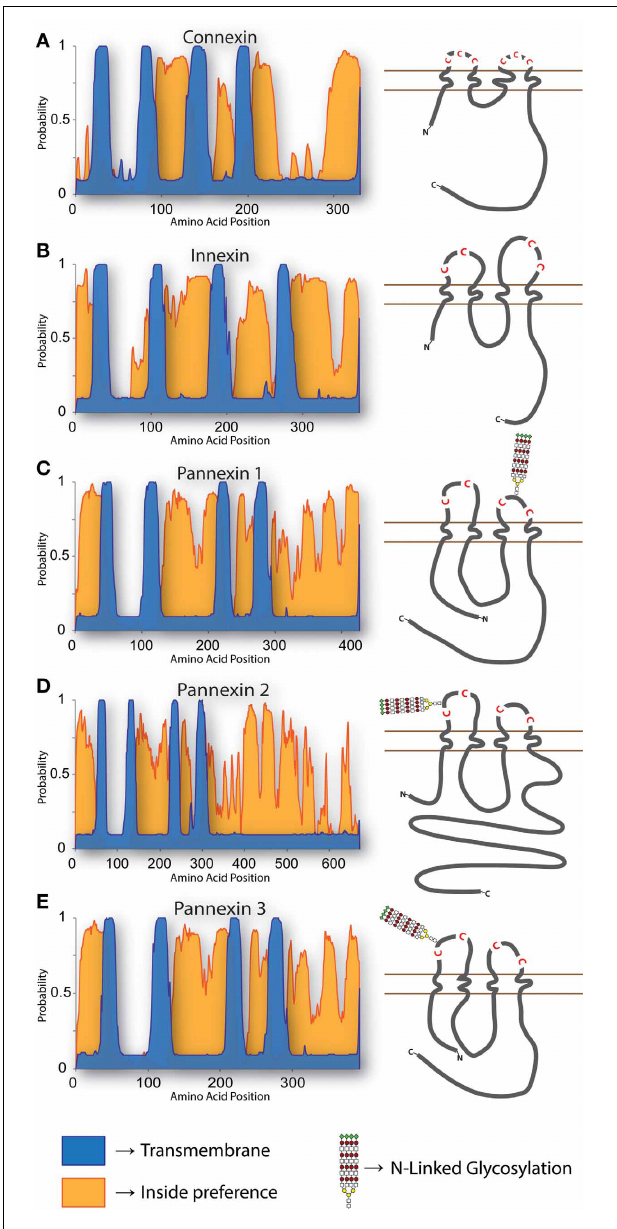
FIGURE 1 | TopologyofCxs,Inxs,andPanxs. Thepredictedarrangementof these proteins within a membrane has been reported on multiple occasions (Hua et al., 2003; Panchin, 2005; Barbe et al., 2006; Magie and Martindale, 2008). Togenerate thepredictions shownhere, multiplepairwisealignments were calculated with the E-INS-i algorithm of MAFFT (Katoh and Standley, 2013) using (A) all 21 human Cxs, (B) 25 C. elegans Inxs, and (C–E) the three Chordate Panx isotypes using protein sequences from mouse, chicken, Xenopus , coelacanth, and Danio . Transmembrane (TM) regions and ER integration orientation were predicted with the OCTOPUS algorithm (Viklund and Elofsson, 2008), using the consensus sequences from each multiple alignment as input. All of the proteins have compelling support for 4 TM domains(blue),whilethe“inside-preference”(orange;basedonclusteringof positivelychargedandpolarresidues)assignedtotheN-terminusandsecond loop strongly suggests that the termini are cytoplasmic. The topologies of each consensus sequence are shown to scale, with relative positions of extracellular loop cysteines and glycosylated asparagines